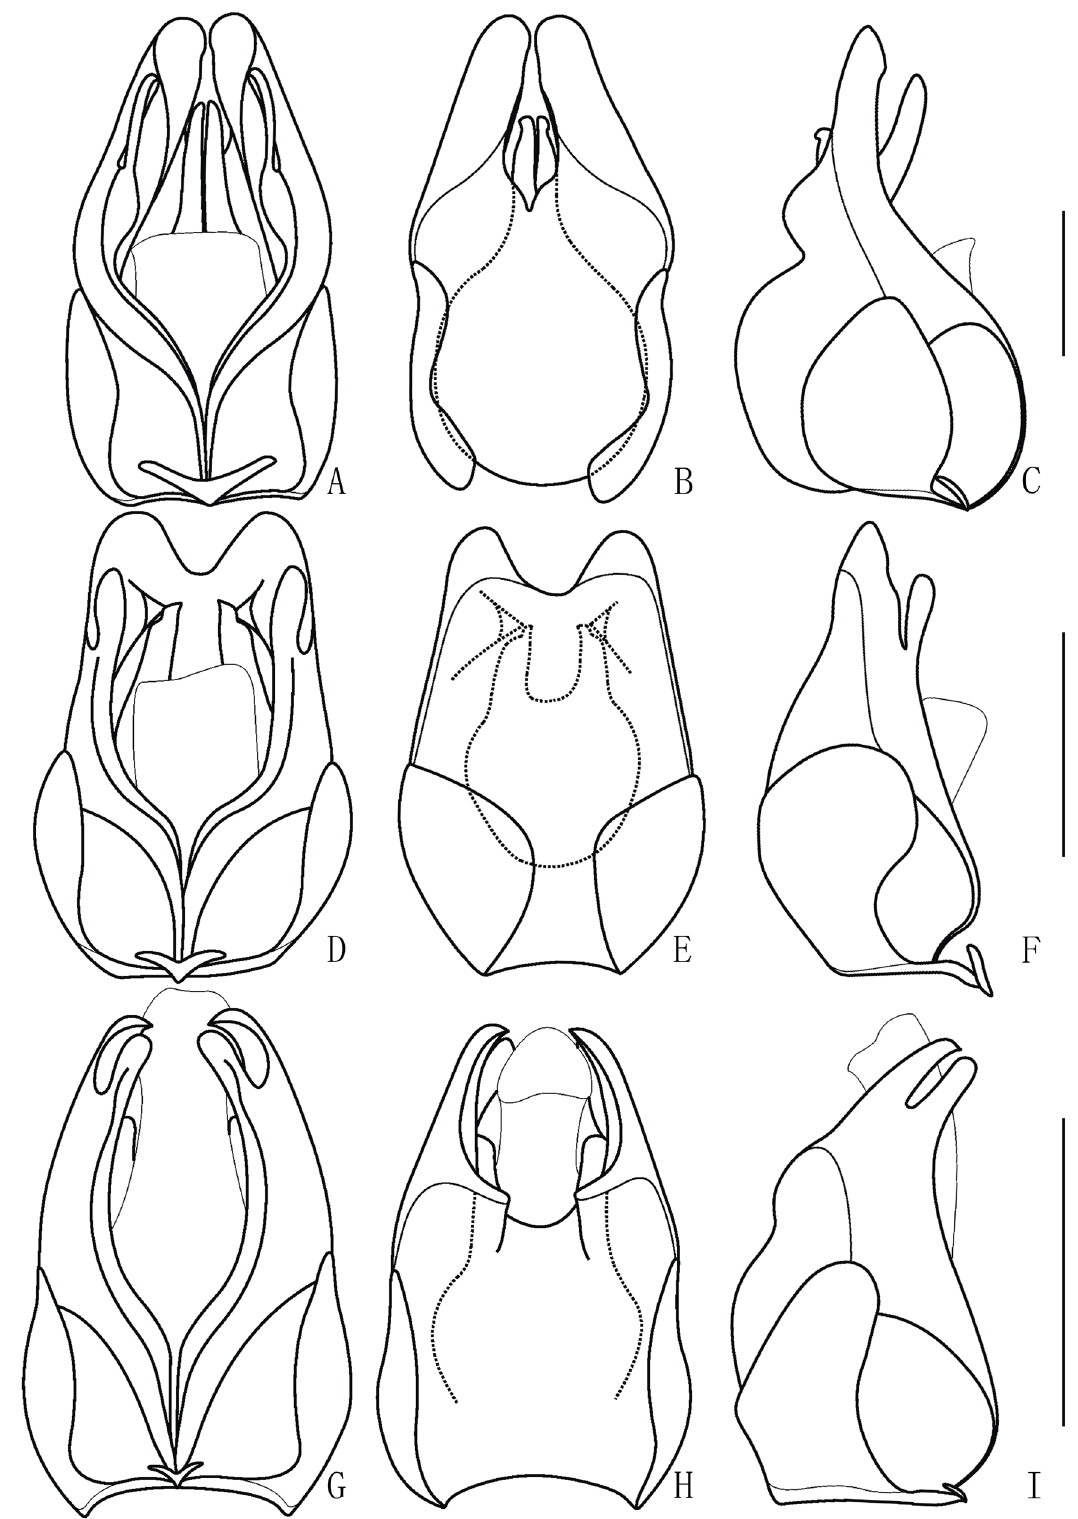
Fig. 6. Aedeagus (A, D, G = ventral view; B, E, H = dorsal view; C, F, I = lateral view). A‒C . Stenothemus grahami Wittmer, 1974 (MHBU, Henan). D‒F . S. minutissimus (Pic, 1933) comb. nov. (IZAS, Sichuan). G‒I . S. gracilis Y. Yang & X. Yang sp. nov. (MHBU HBU(E) 410022). Scale bars = 0.5